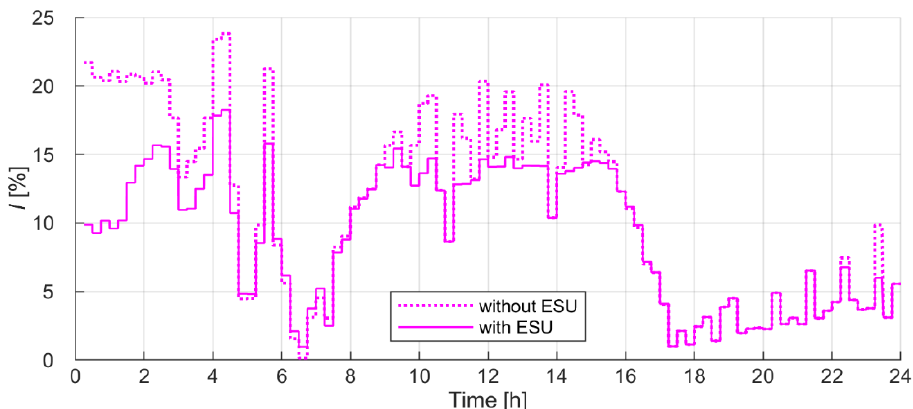
Figure 12. Daily load current variations in line L 522 – 526 (profile A).